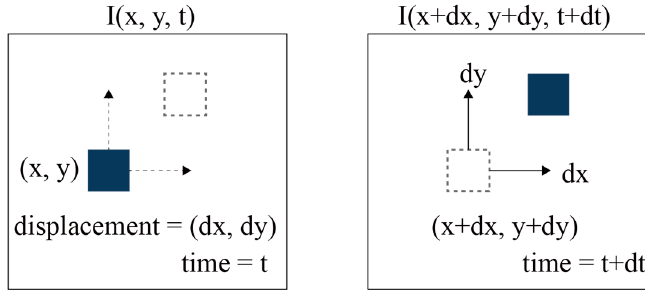
Figure 2. Illustration of motion estimation using optical flow.